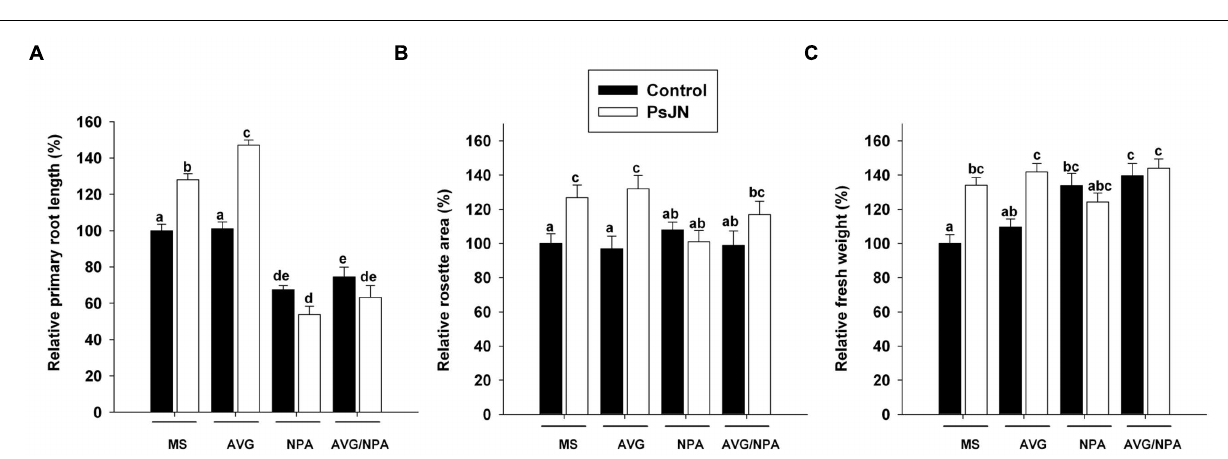
FIGURE 4 | Short-term effects of auxin transport inhibition and/or ethylene biosynthesis inhibition in Arabidopsis growth induction mediated by B. phytofirmans PsJN. Relative primary root length (A) , rosette area (B) , and fresh weight (C) in 14 days old plants inoculated (PsJN) or not (control) with strain PsJN. Plants were also grown without chemical inhibitors (MS), or under the chemical treatment with the auxin efflux inhibitor NPA ( N -1-naphthylphthalamic acid) at 2 µ M and/or with the ethylene biosynthesis inhibitor amino ethoxyvinyl glycine hydrochloride (AVG) at 1.5 µ M. Data are means ± SE of at least 15 plants per treatment. Lowercase letters on top of the bars (a–e) indicate significant statistical differences among treatments. Bars that do not share an identical letter have significant differences, according to a Two-way ANOVA analysis ( p < 0.05), considering inoculation and chemical treatments as factors, and a Tukey post hoc test ( p < 0.05). Results are representative of three different